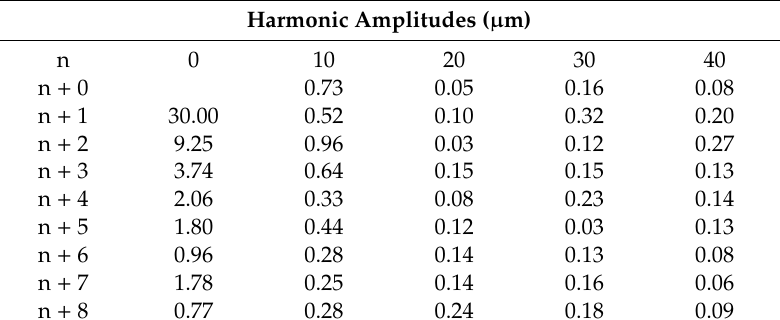
Figure 20. The profile obtained by superimposing the measured roundness profile of journal no. 5 on the full profile of the eccentric movement of the measured roundness profile center ( a ); discrete amplitude spectrum of the superimposed profile ( b ). Table 7. Amplitudes of harmonic components for the profile obtained by superimposing the measured roundness profile of journal no. 5 on the full eccentric movement profile of the center of the measured roundness profile.